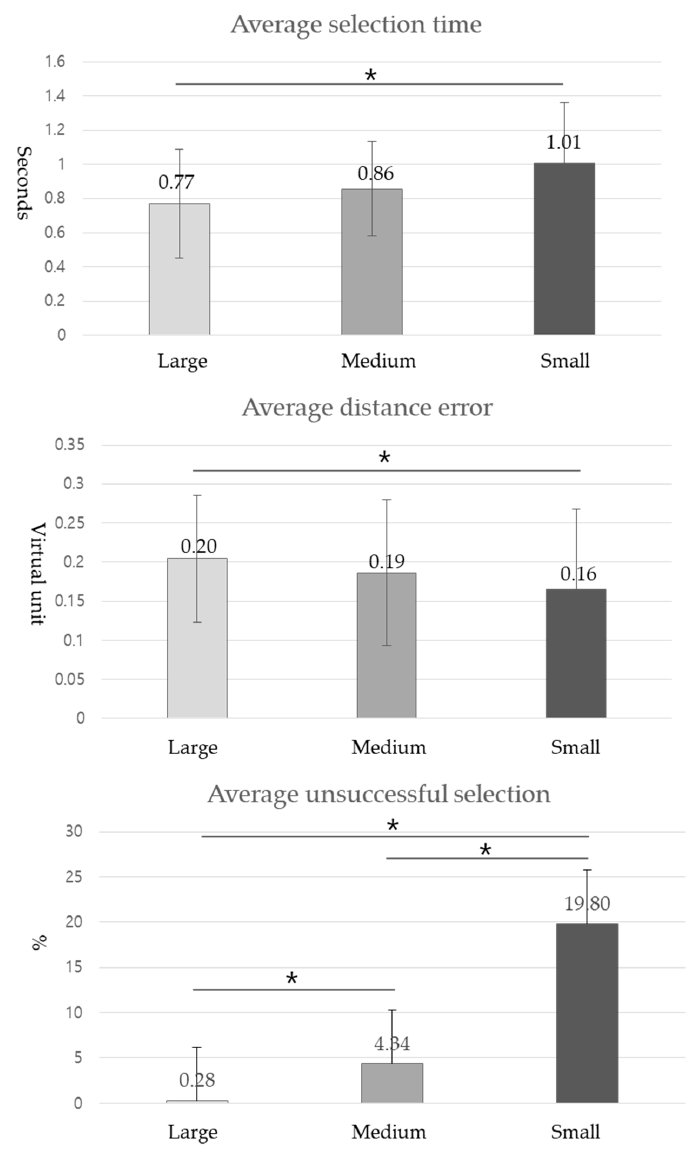
Figure 9. Quantitative performance measures (average selection time, average distance error and average number of unsuccessful selections in percentage) among the three target object sizes. The asterisk mark (*) indicates statistically significant difference.